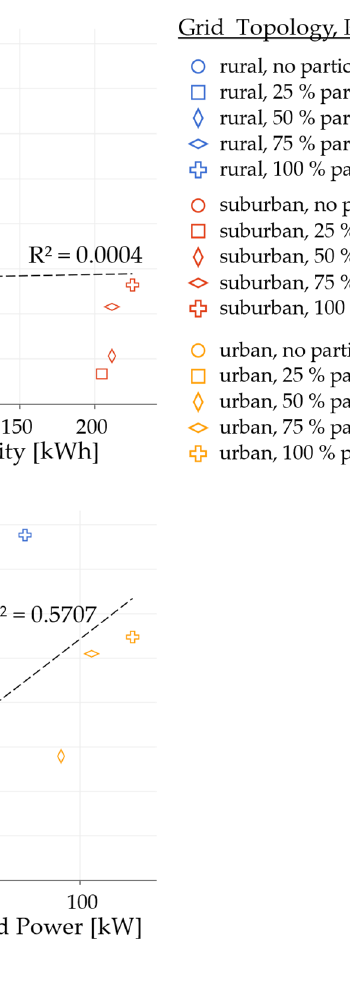
Figure 5. Reduction of the annual demand peak by ‘maximum grid-friendliness’ compared to ‘business-as-usual’ strategy, depending on the design parameters of assets controlled by the renewable energy communities: ( a ) PV generation rated power, ( b ) installed battery capacity, ( c ) heat pumps rated power, ( d ) electric vehicle chargers rated power.